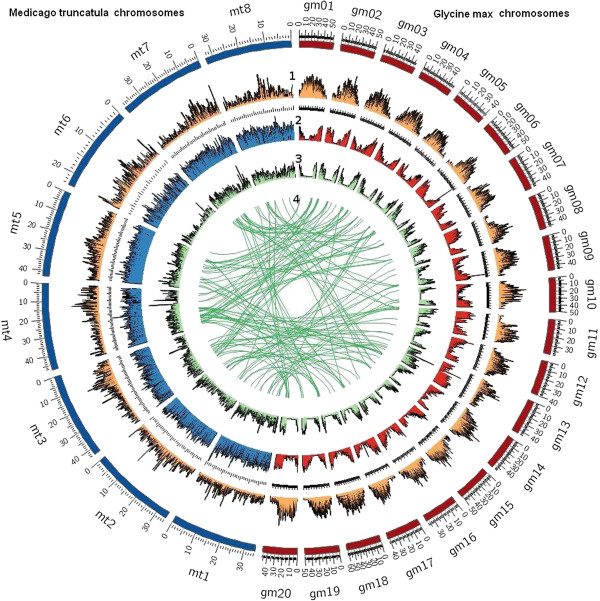
P. alba contigs/isotigs mapped to the M. truncatula and G. max genomes. The 8 and 20 individual chromosomes of M. truncatula and G. Max, respectively, are shown in the outer circle (blue and red, respectively). Relative transposon and gene densities (by 100kb region) on each chromosome are successively displayed inward as follows: (i) Ring 1: transposon density in M. truncatula and G. max (orange), (ii) Ring 2: gene density in M. truncatula (blue) and G. max (red), (iii) Ring 3: P. alba gene density relative to gene densities of M. truncatula and G. max (green) (iv) Ring 4: sequences homologous to G. max, P. alba and M. truncatula altogether (central green lines).